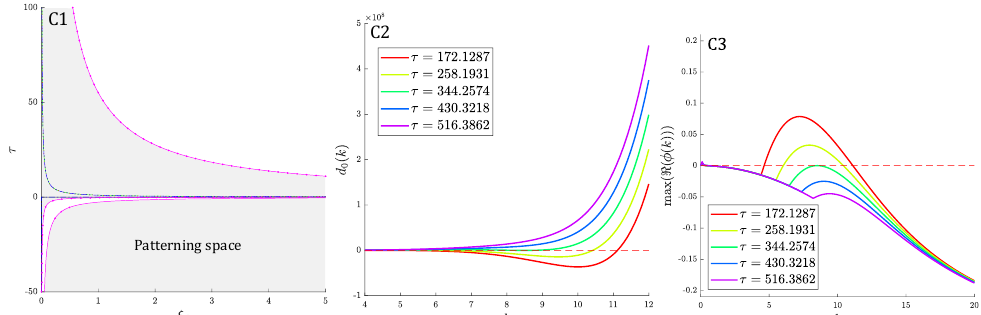
Figure 2. Patterning space, parameter condition and dispersion relations for the coupled poro– mechano–chemical model. ( A1 ): predicted patterning space for a selected interval in ( m 0 , α ) . Parame- ter space: (black plain) boundary built from (15a) for θ 1 ; (green-dashed) boundary built from (15a) for θ 2 ; (red-dot-dot) boundary built from (15b); (blue–dot–dashed) boundary from (15c); (magenta-dot- plain) boundary built from (16). ( A2 ): Coefficient condition on d 0 . Curves are drawn from the critical value m c (green) and for the 25% and 50% increase/decrease parameter value. ( A3 ): associated 0 dispersion relations. Colour code is kept identical with ( A2 ). ( B1 – B3 ): similar analysis for the ( κ 1 , κ 4 ) parameter space. ( C1 – C3 ): similar analysis for the ( τ , ξ f ) parameter space.